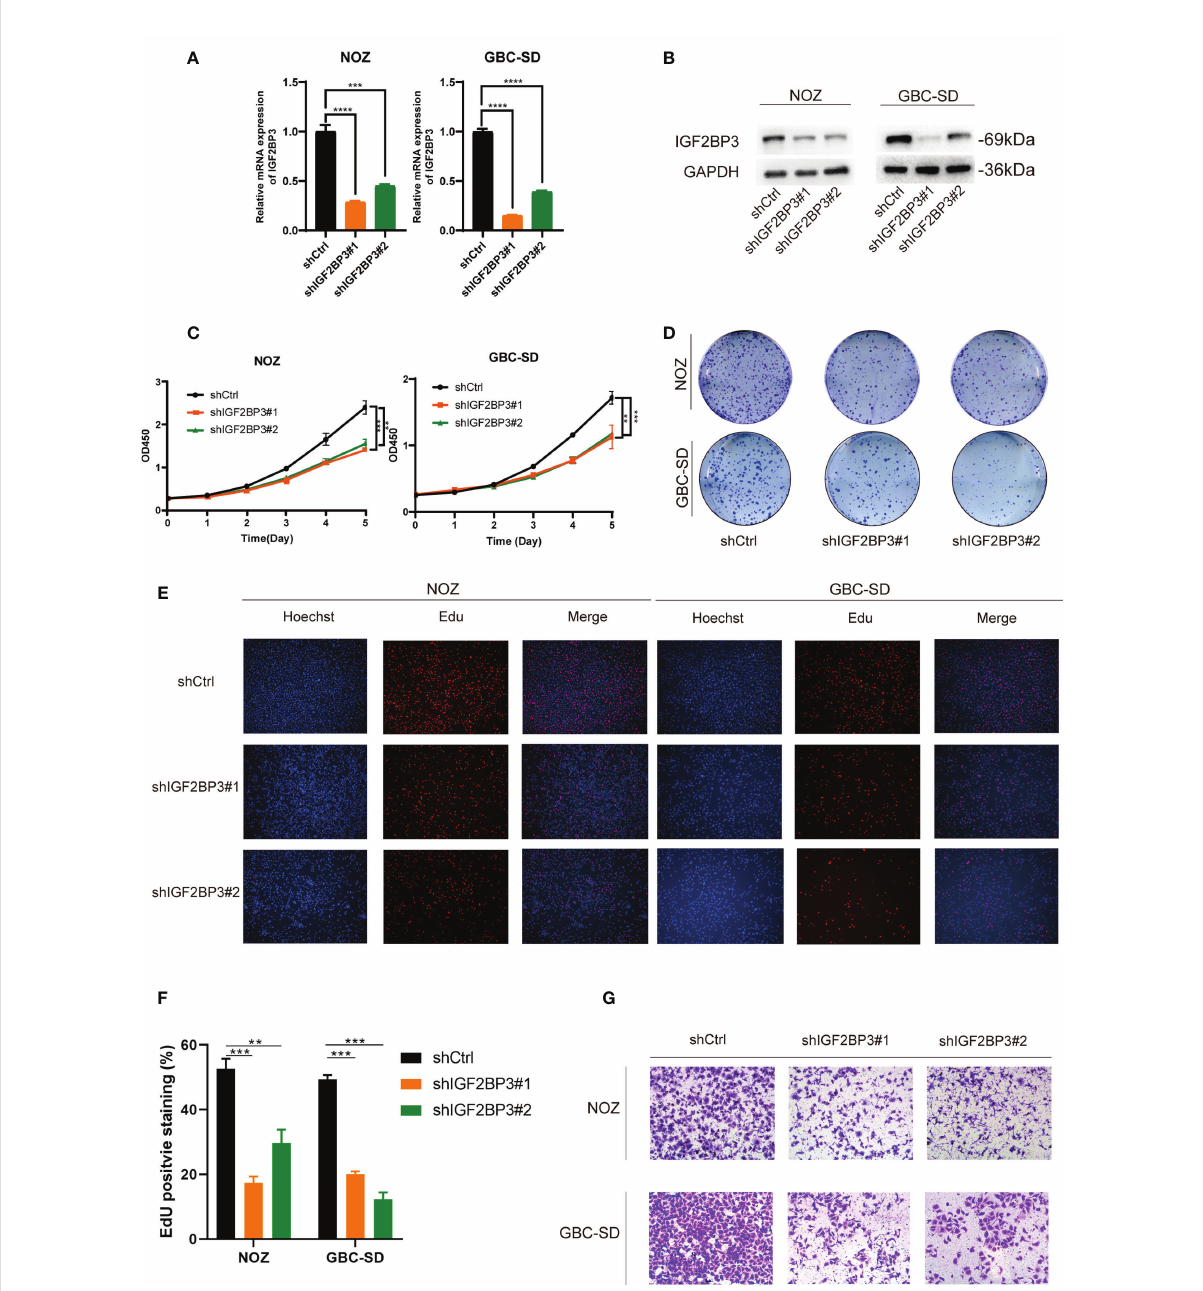
FIGURE 2 Depletion of IGF2BP3 inhibited GBC cell proliferation and migration. (A, B) NOZ and GBC-SD cells were transfected with shRNA to knockdown IGF2BP3. The effect of the transfection was detected by qPCR (A) and western blotting (B) , respectively. (C, D) GBC cell growth was measured by CCK8 (C) and colony formation (D) . (E, F) Cell proliferation was detected by EdU assay using a fl uorescence microscope (E, Hoechst (blue), Edu (red), 100X, scale bar: 100 m m) and statistical signi fi cance was analyzed based on the number of EdU stained cells (F) . (G) Transwell assays were performed to measure migration ability in treated GBC cells (100X, scale bar: 100 m m). Unpaired t test was used in (A, C F) ; data are shown as mean value ± SD; ** P < 0.01, *** P < 0.001 and **** P <